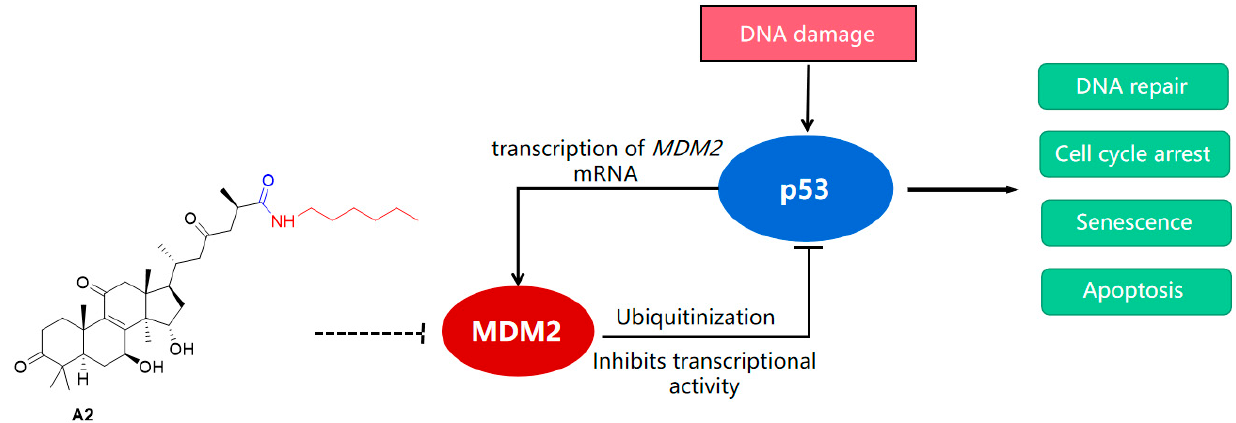
Figure 2. MDM2-p53 negative feedback regulatory loop.